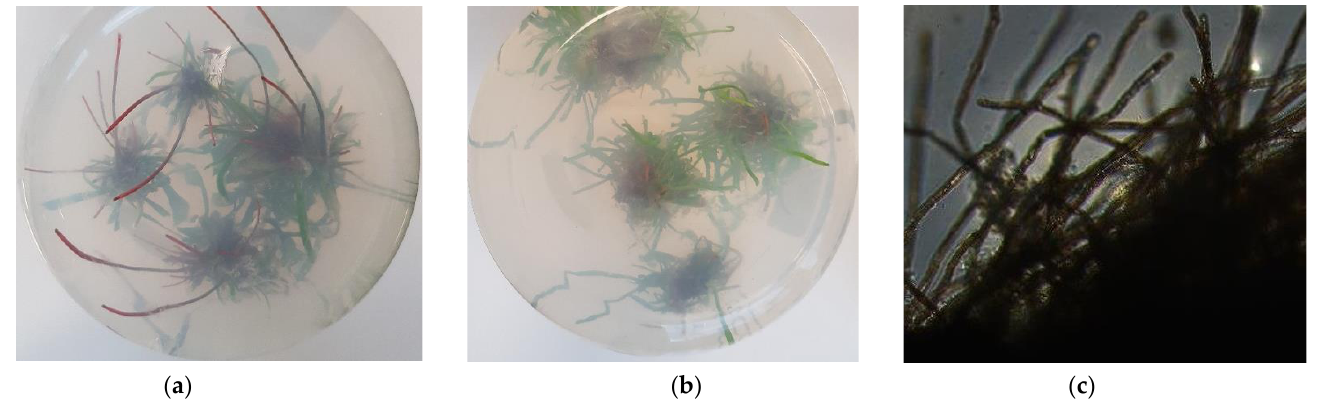
Figure 1. Morphology of transformed roots of S. purpurea obtained after infection of A. rhizogenes strain ATCC 15834. S. purpurea in vitro plantlets exhibiting transformed roots (a) in comparison to wild-type, untransformed roots (b). Micro- scopic analysis of transformed Sarracenia roots (c).